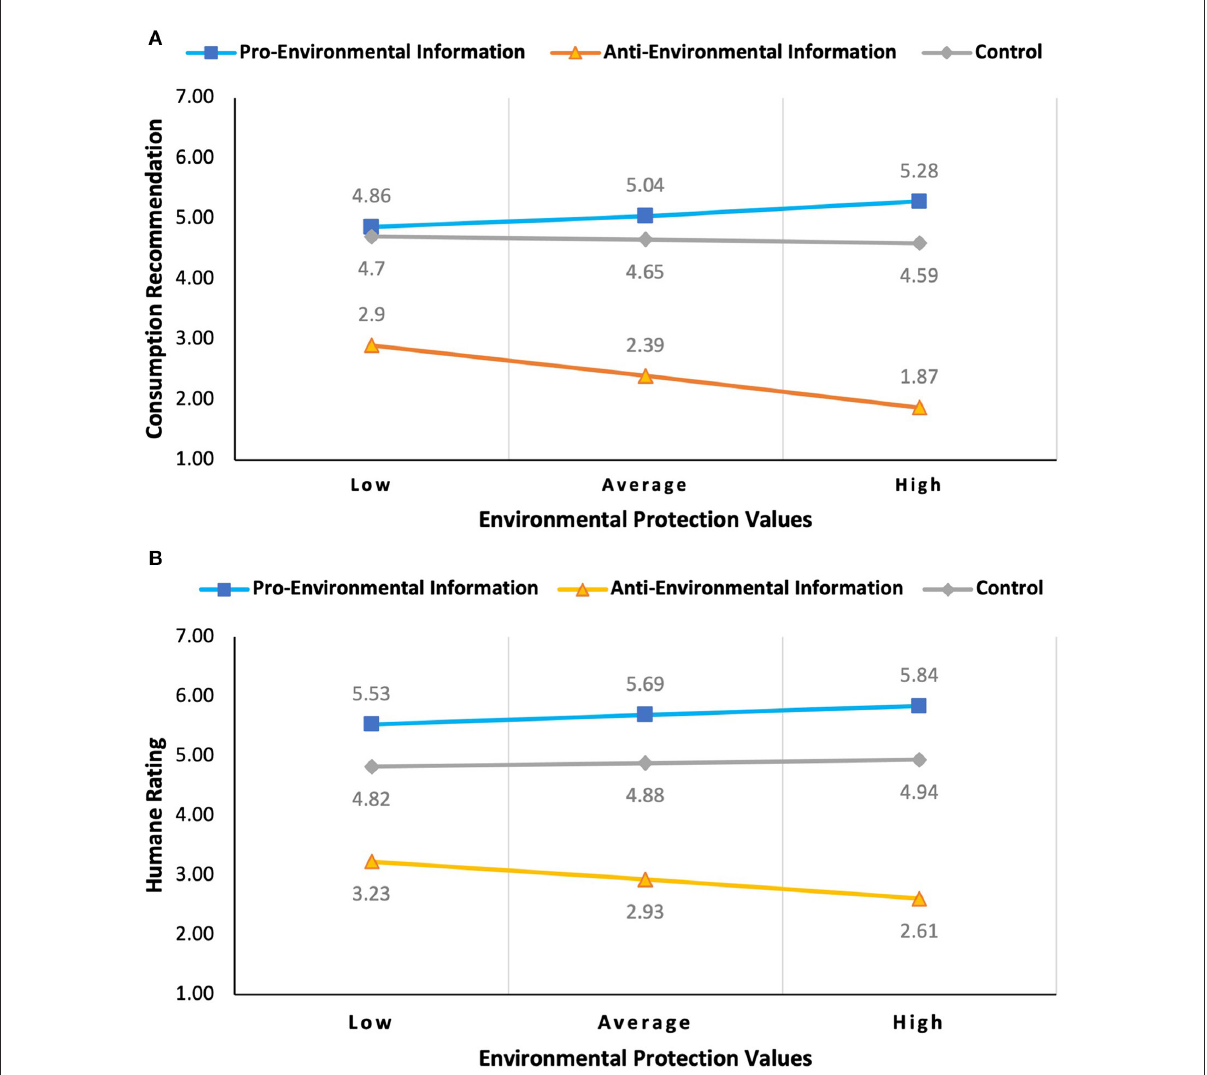
FIGURE3 Simple slopes analysis showing the effect of participants’ environmental protection values on (A) endorsement of the dairy’s cheese (in terms of how frequently they would recommend it be eaten) and (B) how well they perceived the dairy’s treatment of its cows, compared to other brands. Low and High values correspond to one standard deviation below and one standard deviation above the mean,